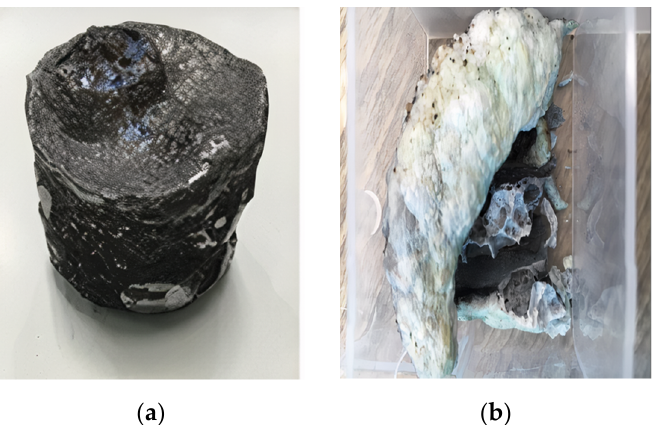
Figure 1. Image of molten metal and molten slag. ( a ) The ingot obtained after cooling; ( b ) the slag obtained after cooling. Table 3. Experimental conditions and weight change for SUS304.